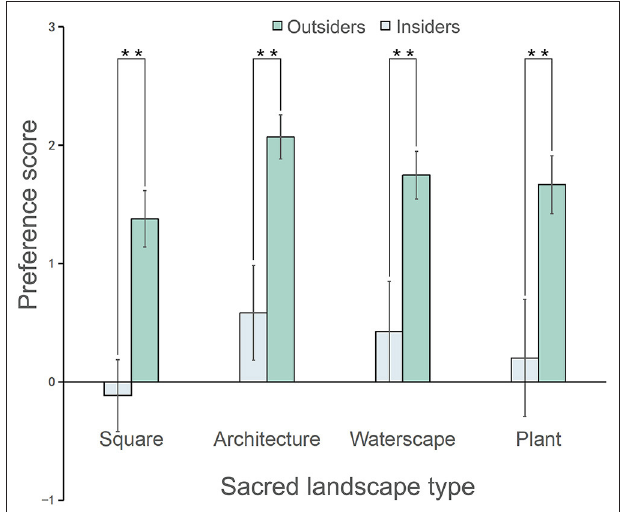
FIGURE 3 | Comparison of the sacred landscape preference scores of the outsiders and insiders (* p < 0.05, ** p < 0.01); the data are shown as means (SD). N = 45 for each group.